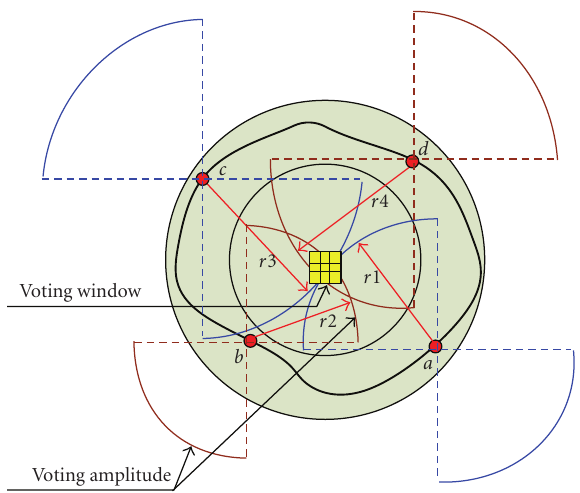
Figure 6: Voting window and voting